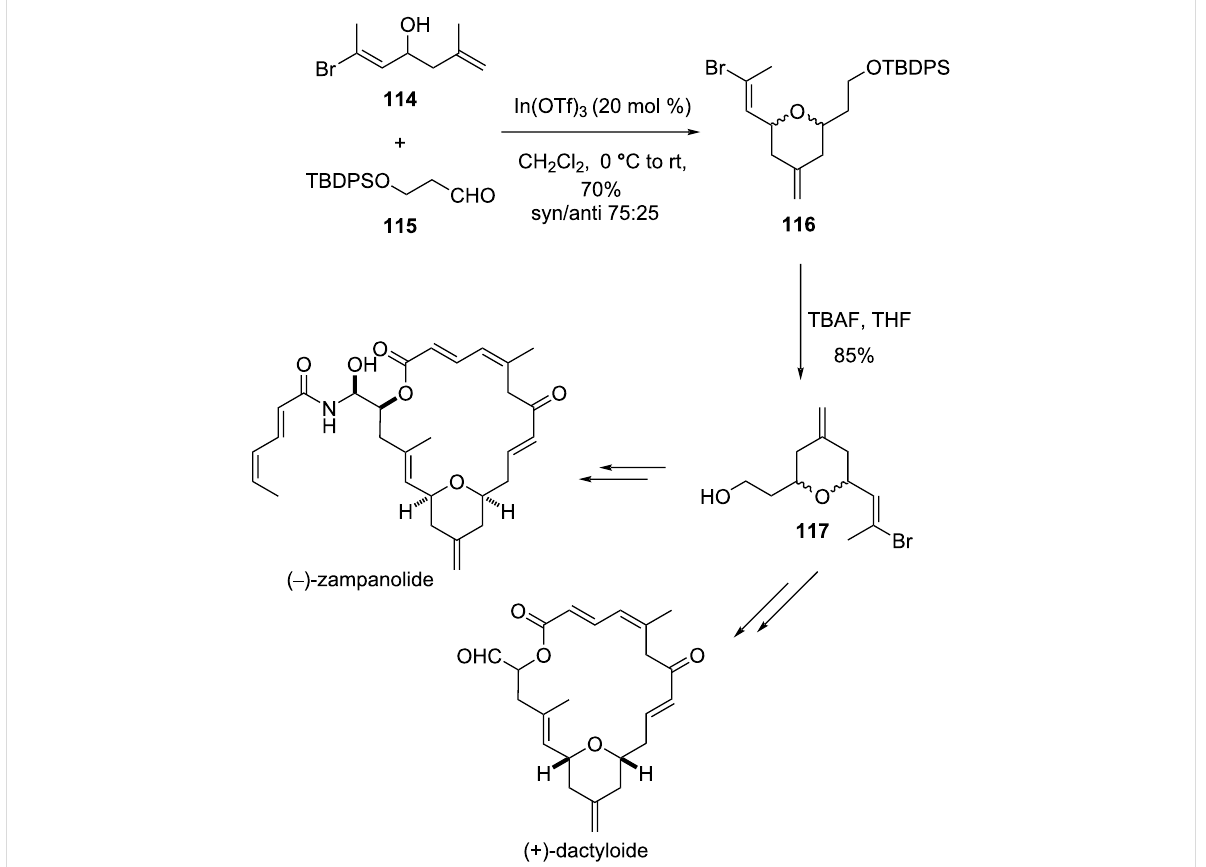
Scheme 27: Loh and co-workers’ strategy for the synthesis of zampanolide and dactylolide.